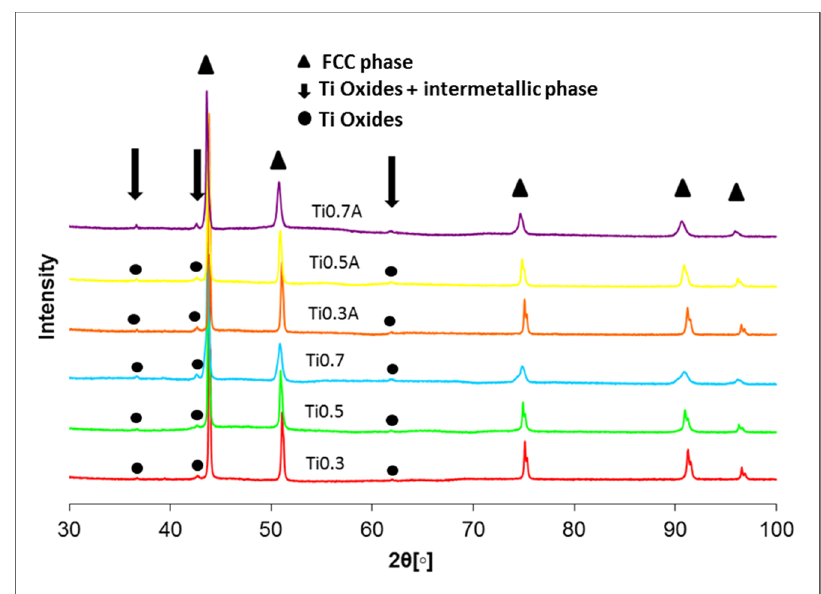
Figure 4. XRD spectrums of sintered an annealed Tix alloys.